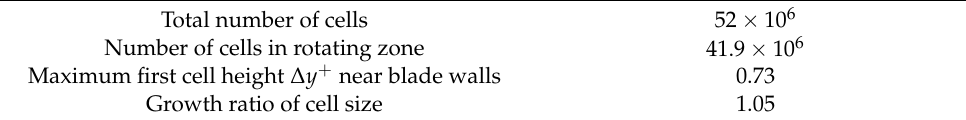
Table 3. Time-averaged performance of the fan.